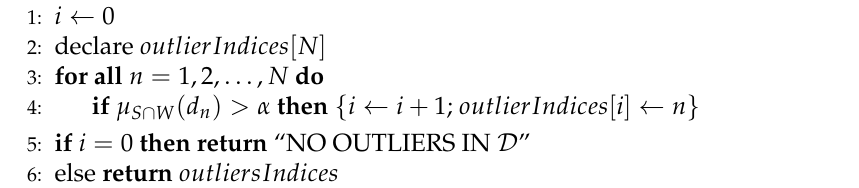
Algorithm 4 Recognizing outliers detected with Algorithm